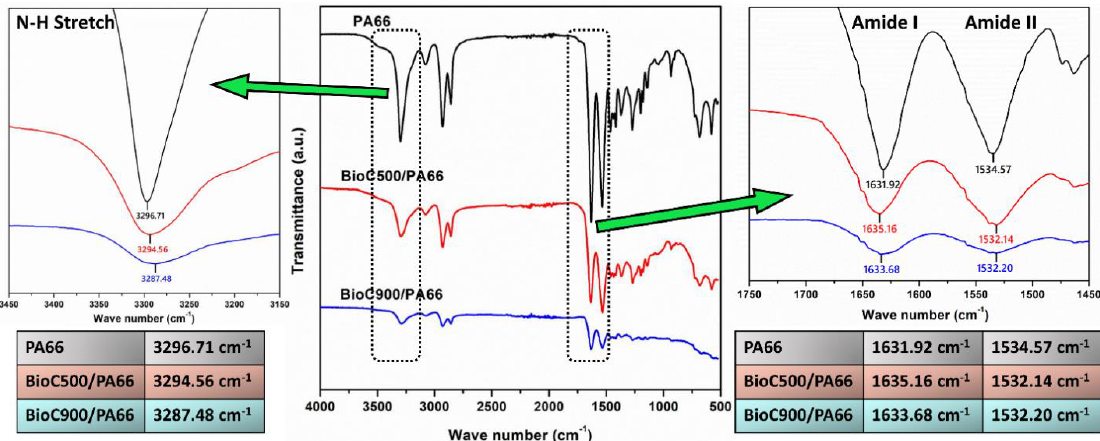
Figure 4. FTIR spectra of PA66 and its composites with low pyrolysis temperature and high pyrolysis temperature BioC.